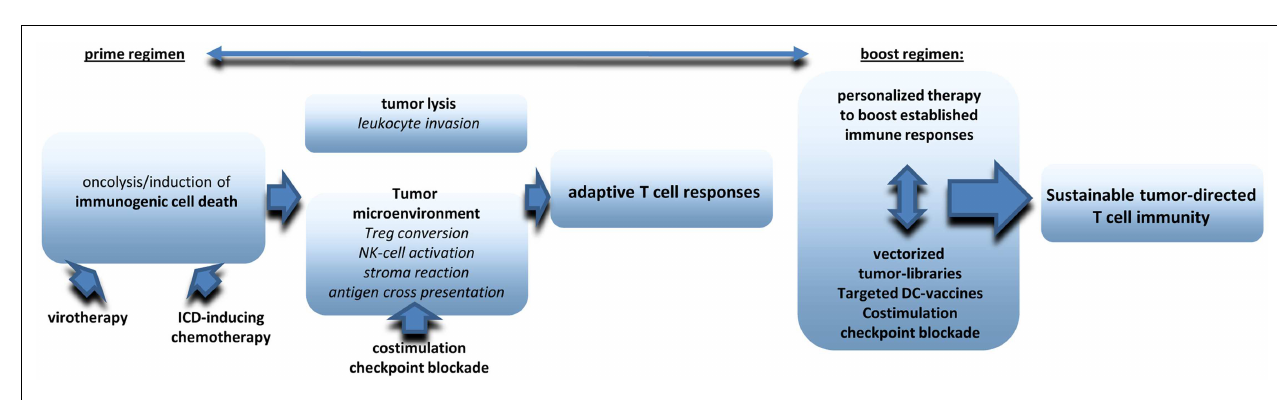
FIGURE 2 |The figure provides an overview on critical components to be included in multimodale virotherapy-based therapies that work like prime-boost strategies